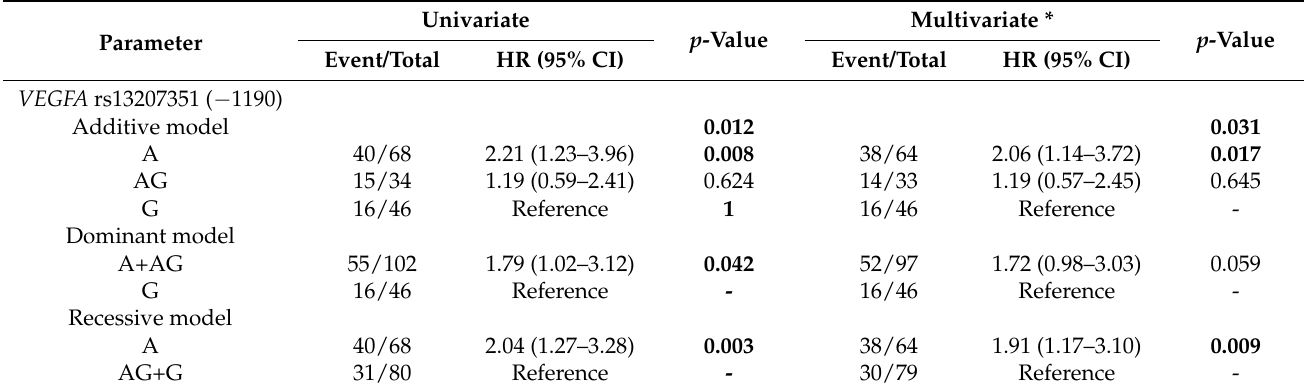
Table 3. Hazard ratios and 95% CIs estimated by Cox regression analysis under additive, dominant, and recessive genetic models for VEGFA rs13207351 ( − 1190) in non-NPC